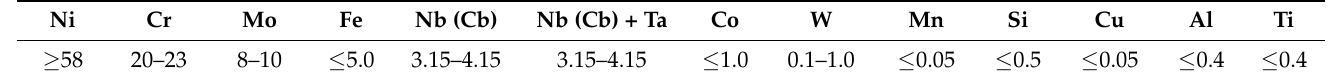
Figure 1. Inconel 625 Powder morphology.